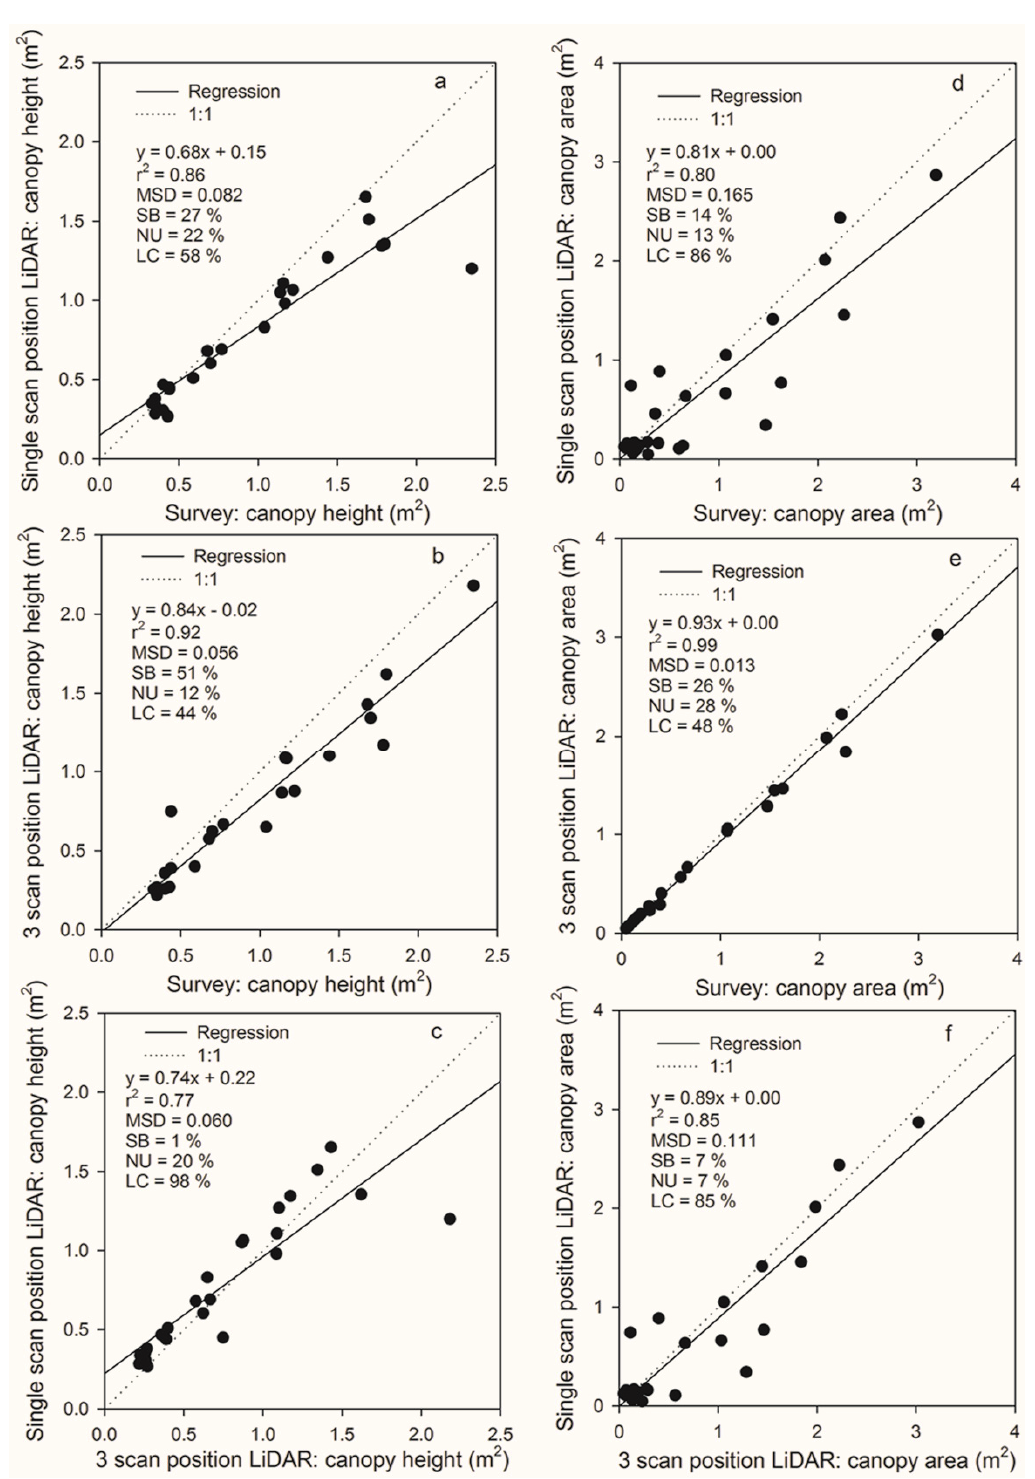
Figure 3. Relationships of LiDAR measurements performed from one scan position or three scan positions and total station survey for canopy height ( a – c ) and area ( d – f ) of individuals within the study plot. MSD is the mean squared deviation and has components of standard bias (SB), non-unity (NU), and lack of correlation